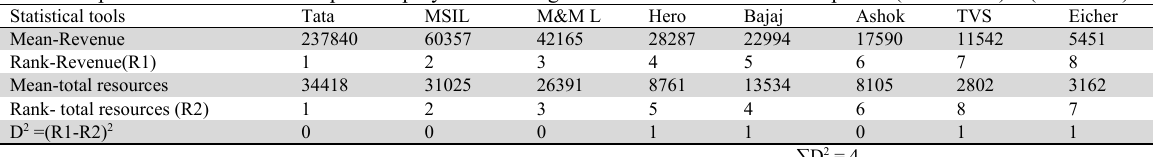
Relationship between revenue and capital employed of leading Indian automobile sector companies (2011-2020). (Rs. in Cr.) Statistical